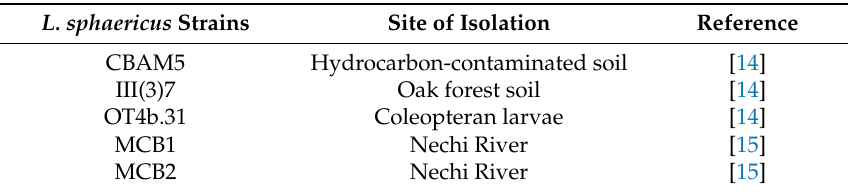
Table 1. Strains of L. sphaericus evaluated in the biosorption